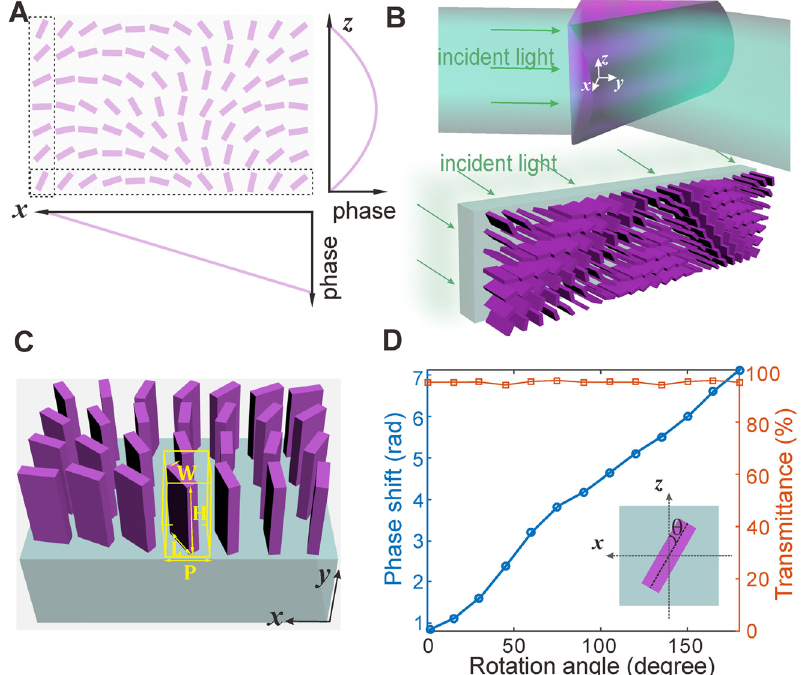
right-handed circularly polarized